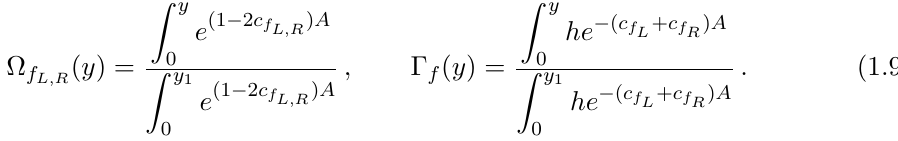
(cid:14)g f =g f (left panel) and L L j j ; c (cid:22) ; c (cid:28) ; c b ) = (0 : 85 ; 0 : 65 ; 0 : 55 ; 0 : R R R R